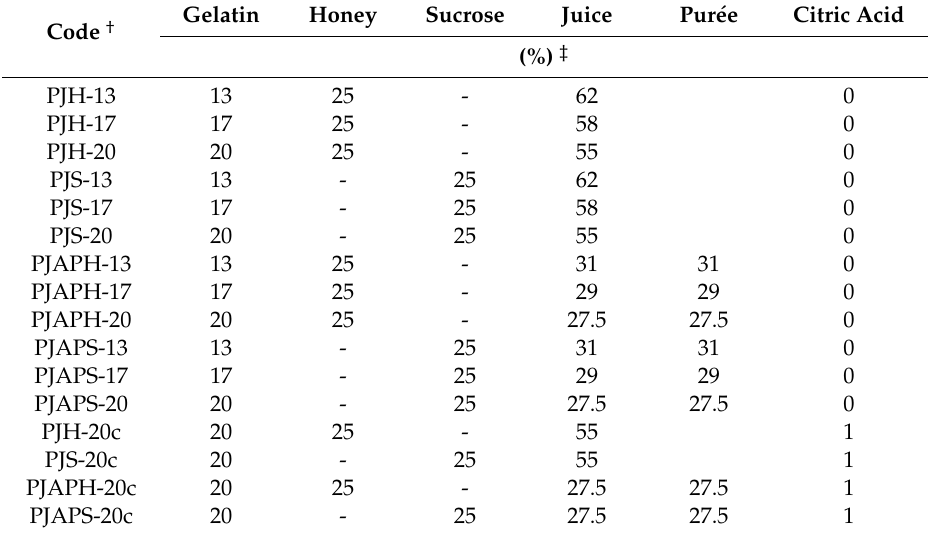
Table 1. Formulation of jelly candies consisting of pomegranate juice and apple pur é